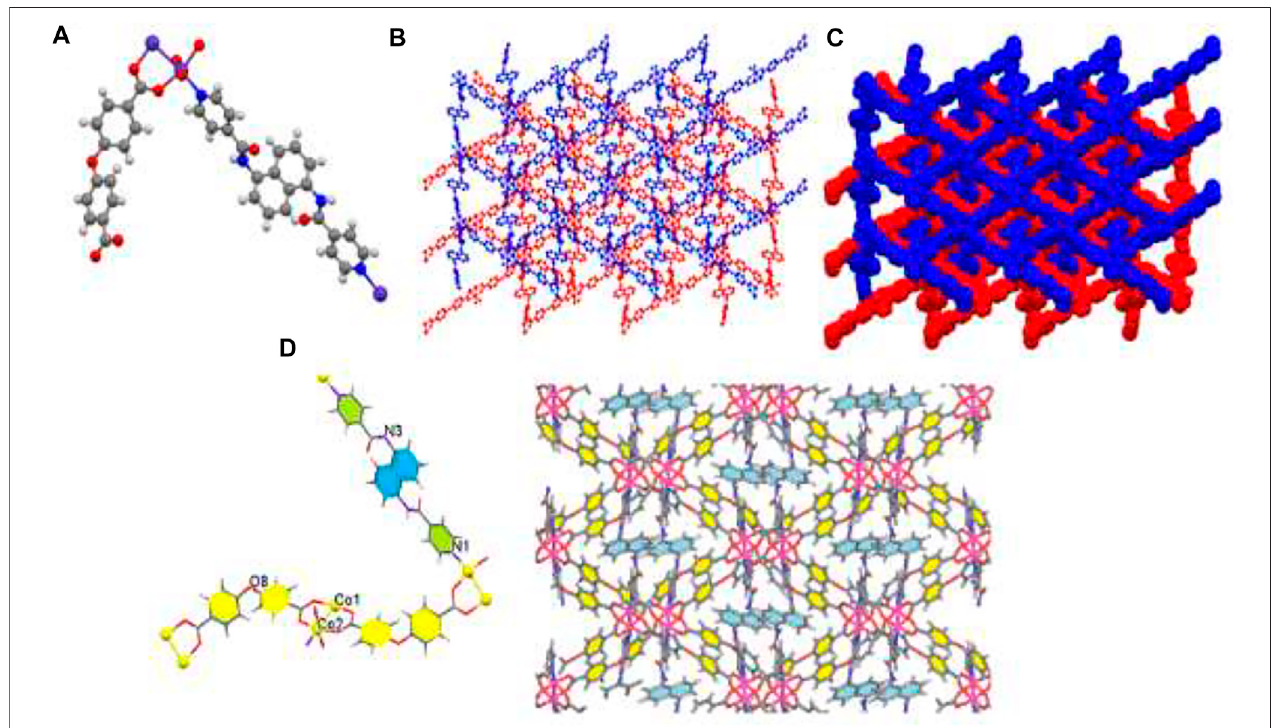
FIGURE 3| Molecular diagram of TMU-51 (A) , Scheme of3D structure (B) , the two-fold interpenetration of TMU-51 (C) , and representation of the arrangementof bpfn pillar ligands inside the channel walls (with pore scale of 14.83 Å). The benzene are colored yellow (D) .